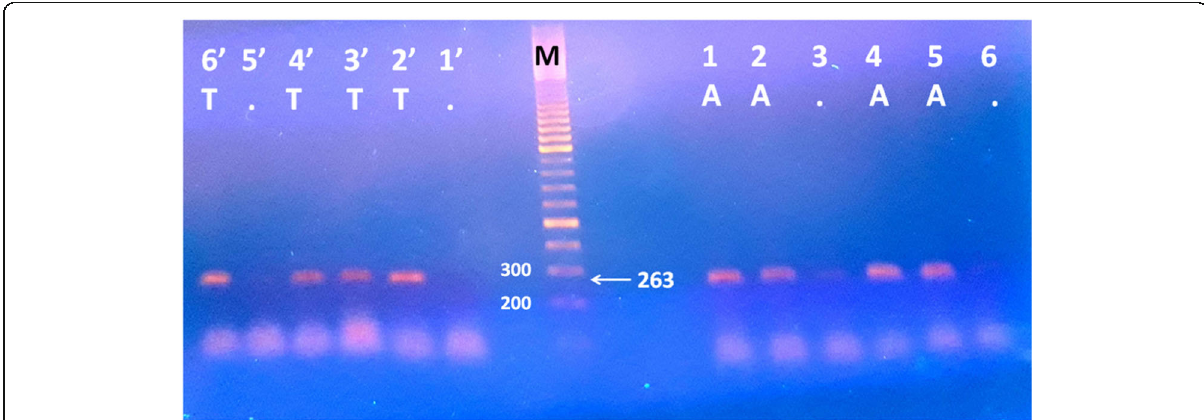
Fig. 2 IFN- γ + 874 A/T polymorphism in CL patients. Lane M indicate DNA ladder 100 bp, lanes 1 and 1 ’ represent AA genotype for sample 1, lanes 2 and 2` represent AT genotype for sample 2, lanes 3 and 3` represent TT genotype for sample 3, lanes 4 and 4` represent AT genotype for sample 4, lanes 5 and 5` represent AA genotype for sample 5 and lanes 6 and 6` represent TT genotype for sample 6. All IFN- γ +874 A/T genotypes detected at the same size (263 bp) by the amplification refractory mutation